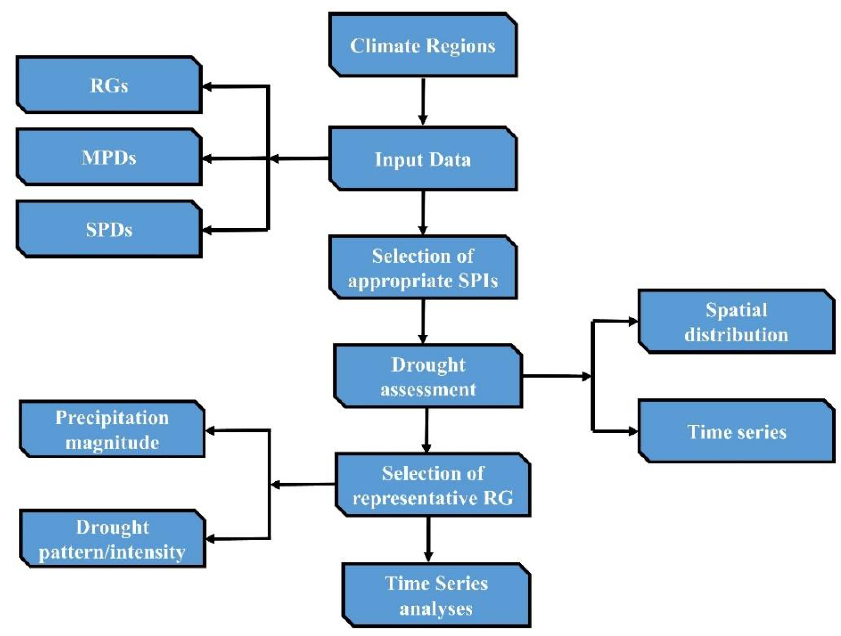
Figure 2. Flowchart of the proposed methodology.